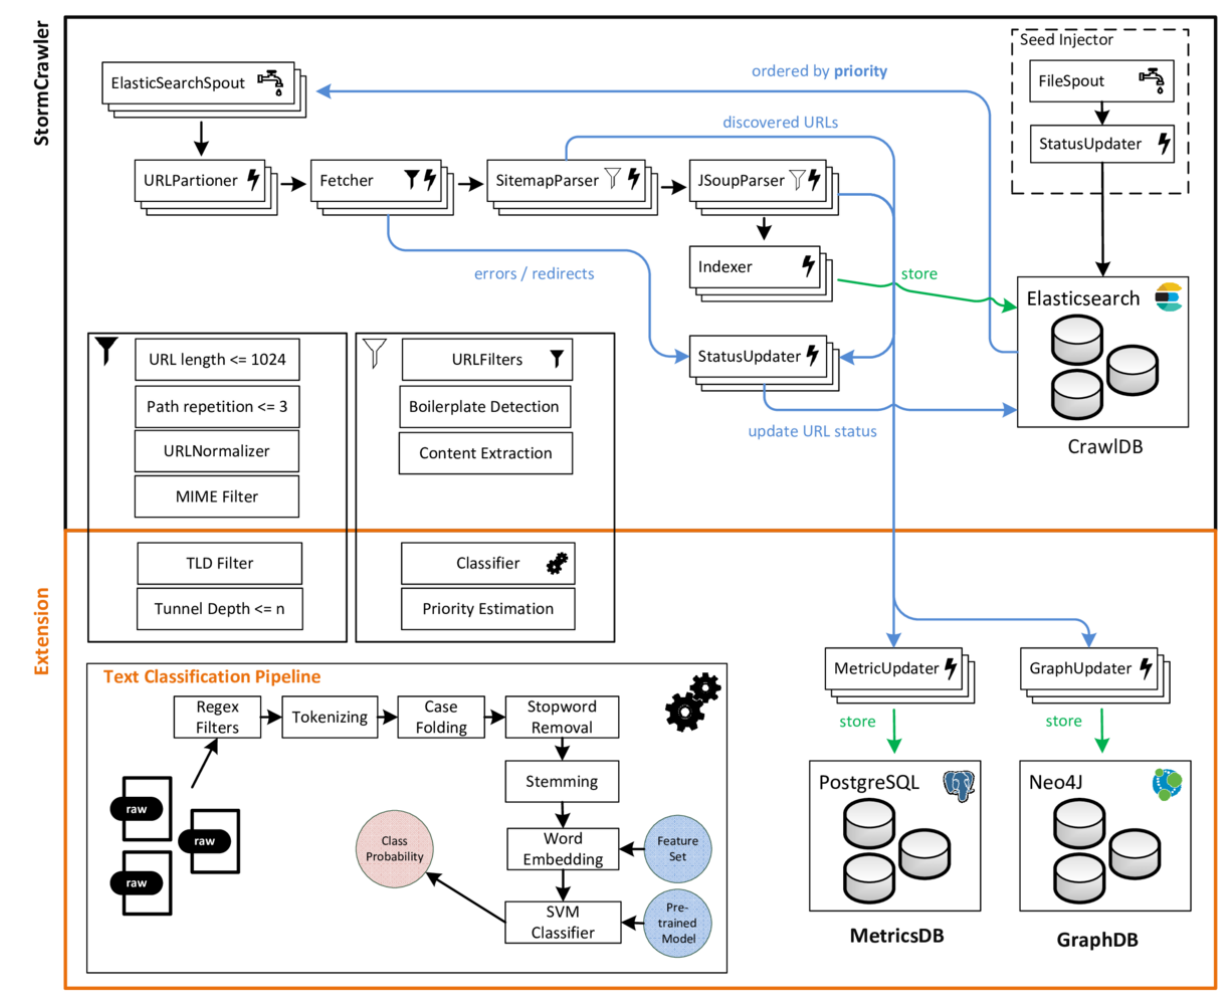
Figure 2. Architecture of a focused crawler based on the StormCrawler software development kit. Spouts (tap symbol) emit data (here: URLs), bolts (lightning symbol) process data (ie fetch, parse, and store the extracted content). Bolts can be enhanced with URL filters (white filter symbol) or parse filters (black filter symbol). URL filters are used to remove URLs based on predefined criteria. Parse filters include URL filters but are primarily used to clean the parsed content and compute topic relevance and